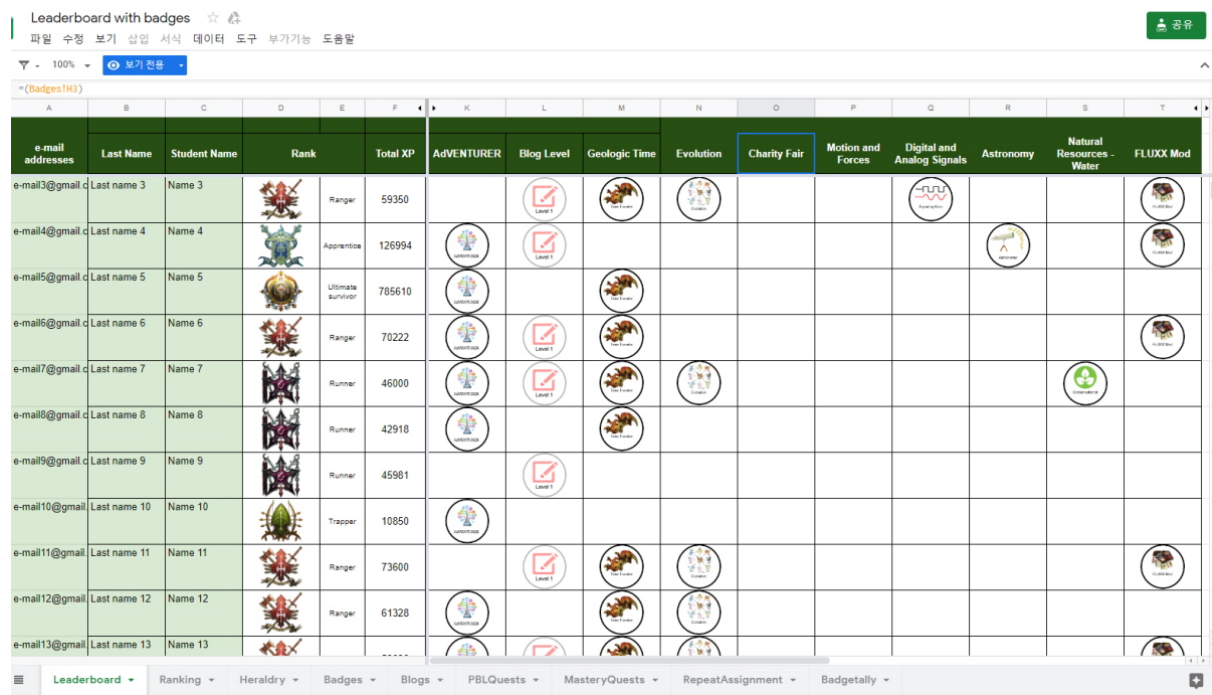
Figure 6. Leaderboard provided by Teaching Above the